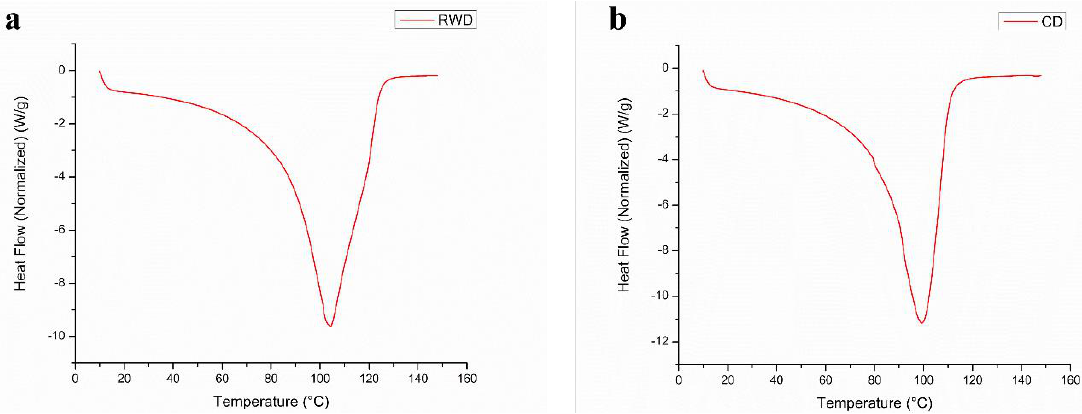
Figure 8. Thermal analysis of ( a ) RW-dried and ( b ) convective-dried onion